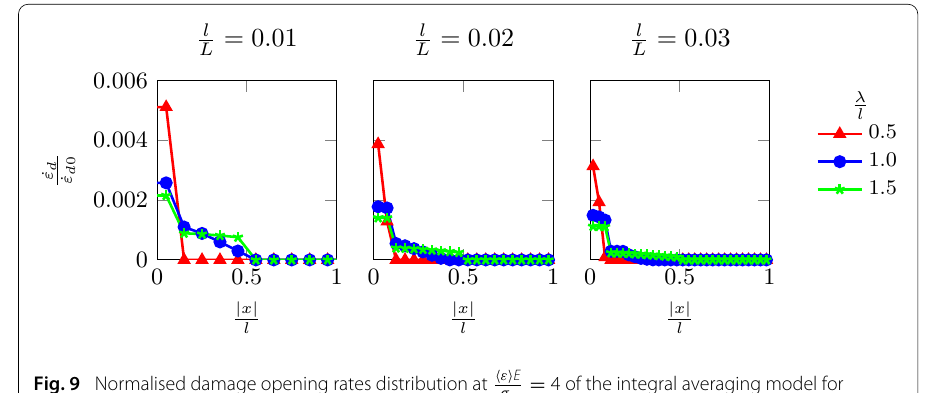
Fig. 9 Normalised damage opening rates distribution at (cid:3) ε (cid:4) E σ different interphase thicknesses and nonlocal length scales